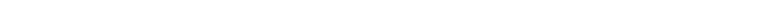
Additional file 2: Figure S1. Multiple sequence alignment of BAF proteins from different species: Caenorhabditis elegans (NP_499085.1 Barrier-to-autointegration factor 1), Drosophila melanogaster (NP_001260220.1 barrier to autointegra- tion factor), Xenopus laevis : factor A (NP_001084558.1 barrier-to-autointegration factor A) and factor B (NP_001087314.1 barrier-to-autointegration factor B), Mus musculus (NP_001033320.1 barrier-to-autointegration factor), and Homo sapiens (NP_003851.1 barrier-to-autointegration factor). The darker blue color indicates higher similarity. The numbering above the multiple sequence alignment is for D. melanogaster . All sequences were aligned with CLUSTALX v. 2.0. Each alignment was edited in JALVIEW v. 2.8. and individually corrected for inaccurate fragments. (PNG 33 kb) Additional file 3: Figure S2. Multiple sequence alignment of MAN1 proteins from different species: Caenorhabditis elegans (NP_496944.1 LEM protein 2), Drosophila melanogaster (NP_001286812.1 MAN1), Xenopus laevis : (NP_001082578.1 LEM domain containing 3 S homeolog), Mus musculus (NP_001074662.2 inner nuclear membrane protein Man1), and Homo sapiens : isoform 1 (NP_055134.2 inner nuclear membrane protein Man1 isoform 1) and isoform 2 (NP_001161086.1 inner nuclear membrane protein Man1 isoform 2). The darker blue color indicates higher similarity. The numbering above the multiple sequence alignment is for D. melanogaster . All sequences were aligned with CLUSTALX v. 2.0. Each alignment was edited in JALVIEW v. 2.8. and individually corrected for inaccurate fragments. (PNG 309 kb) Additional file 4: Figure S3. Multiple sequence alignment of LBR proteins from different species: Drosophila melanogaster : isoform A (NP_611608.1 lamin B receptor, isoform A), isoform B (NP_726115.1 lamin B receptor, isoform B), isoform C (NP_726114.1 lamin B receptor, isoform C), Xenopus laevis (NP_001079301.1 lamin B receptor S homeolog), Mus musculus (NP_598576.2 lamin-B receptor), and Homo sapiens (NP_002287.2 lamin-B receptor). Isoforms A and B of LBR proteins in D. melanogaster are shown on one alignment because they have the same amino acid sequence. The darker blue color indicates higher similarity. The numbering above the multiple sequence alignment is for D. melanogaster . All sequences were aligned with CLUSTALX v. 2.0. Each alignment was edited in JALVIEW v. 2.8. and individually corrected for inaccurate fragments. (PNG 217 kb) Abbreviations BAF: Barrier-to-autointegration factor; CNS: Central nervous system; INM: Inner nuclear membrane; LBR: Lamin-B receptor; LINC complex: Linker of nucleoskeleton and cytoskeleton complex; MTOC: Microtubule-organizing center; NE: Nuclear envelope; NEBD: Nuclear envelope breakdown; NL: Nuclear lamina; NLS: Nuclear localization signal; NPC: Nuclear pore complex; ONM: Outer nuclear